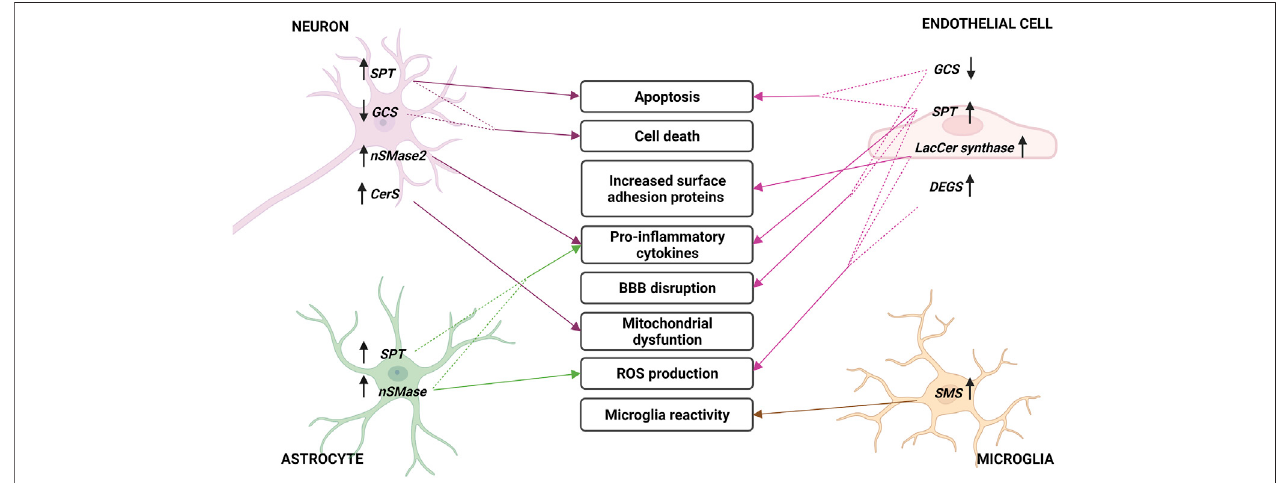
FIGURE 5 | Sphingolipid metabolism enzymes involved in cerebral ischemia. Changes in sphingolipid enzymes in different cell types of brain parenchyma and endothelium during stroke. In the middle, the consequences of these variations are described, indicated with arrows. Arrows next to enzymes describe an increase (up) or decrease (down) in their expression or activity. Acronyms represent: serine palmitoyltransferase (SPT), neutral sphingomyelinase (nSMase), Lactosyl-ceramide synthase (LacCer synthase), dihydroceramide desaturase (DEGS), sphingomyelin synthase (SMS), glucosylceramide synthase (GCS) and ceramide synthase